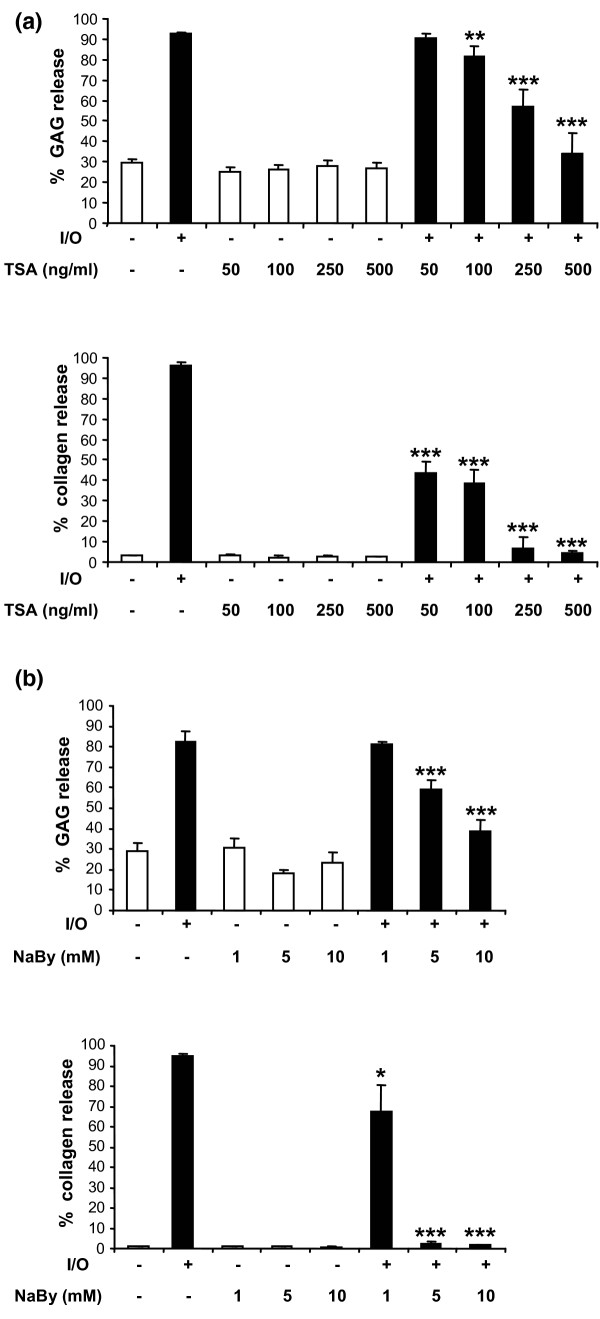
Histone deacetylase inhibitors block cartilage glycosaminoglycan and collagen loss induced by IL-1α/OSM. Bovine nasal cartilage discs were cultured in the presence or absence of I/O (a combination of IL-1α and oncostatin M (OSM)) and a histone deacetylase inhibitor, either (a) I/O (1 ng/ml IL-1α, 10 ng/ml OSM) with trichostatin A (TSA) or (b) I/O (0.2 ng/ml IL-1α, 2 ng/ml OSM) with sodium butyrate (NaBy). Cartilage was incubated until day 7 and supernates were harvested and replaced with fresh reagents until day 14. Glycosaminoglycan (GAG) release is shown as at day 7 and was assayed using the dimethylmethylene blue method. Collagen release is shown as at day 14 and was measured using an assay for hydroxyproline. Viability was assessed by measuring lactate dehydrogenase in the conditioned medium. Assays were performed at least twice using quadruplicate samples; means ± standard deviations are represented. *P < 0.05, **P < 0.01, ***P < 0.001.